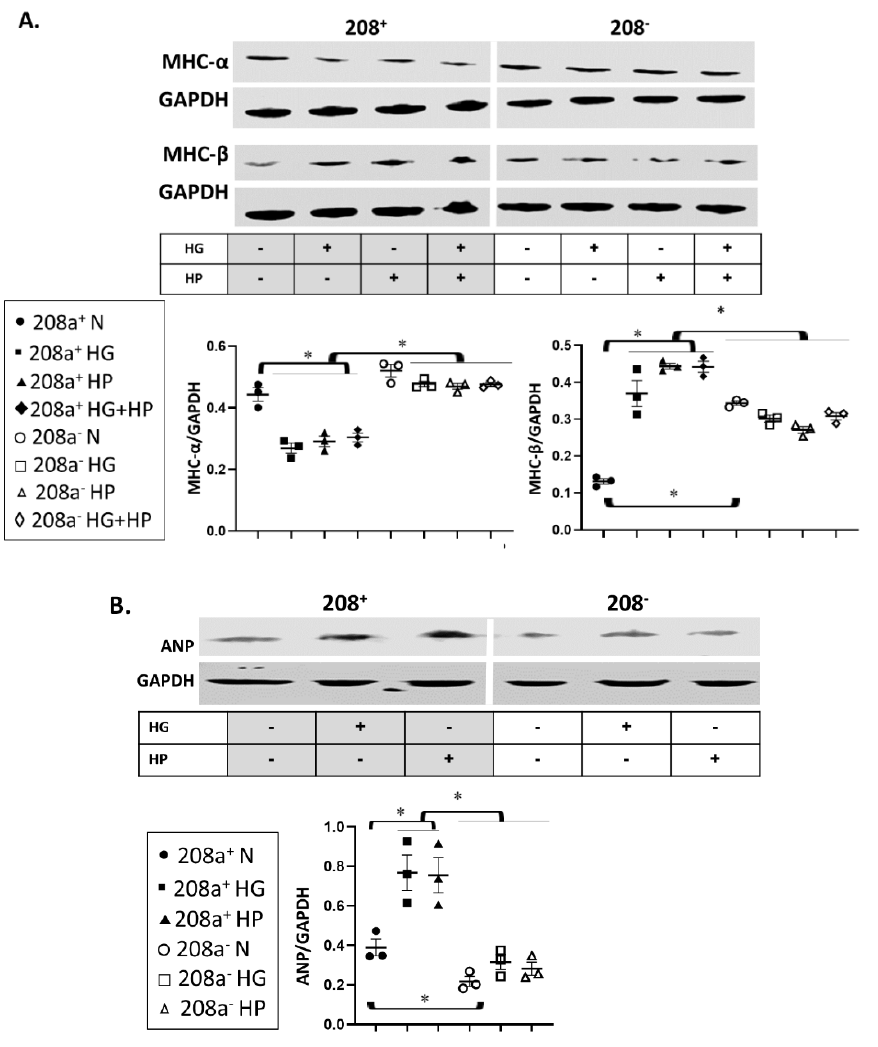
Figure 3. MiR 208a regulates the cardiomyocyte stress response. SV40 human cardiomyocytes were incubated in DMEM with 5 mM glucose, 25 mM glucose (high glucose, HG), or 20 µM bovine serum albumin (BSA)-bound palmitate (high palmitate, HP) for 24 h, and markers of pathologic cardiomyocyte hypertrophy were assessed. ( A ). MHC- α , myosin heavy chain- α ; MHC- β , myosin heavy chain- β ; GAPDH, glyceraldehyde 3-phosphate dehydrogenase. ( B ). ANP, atrial